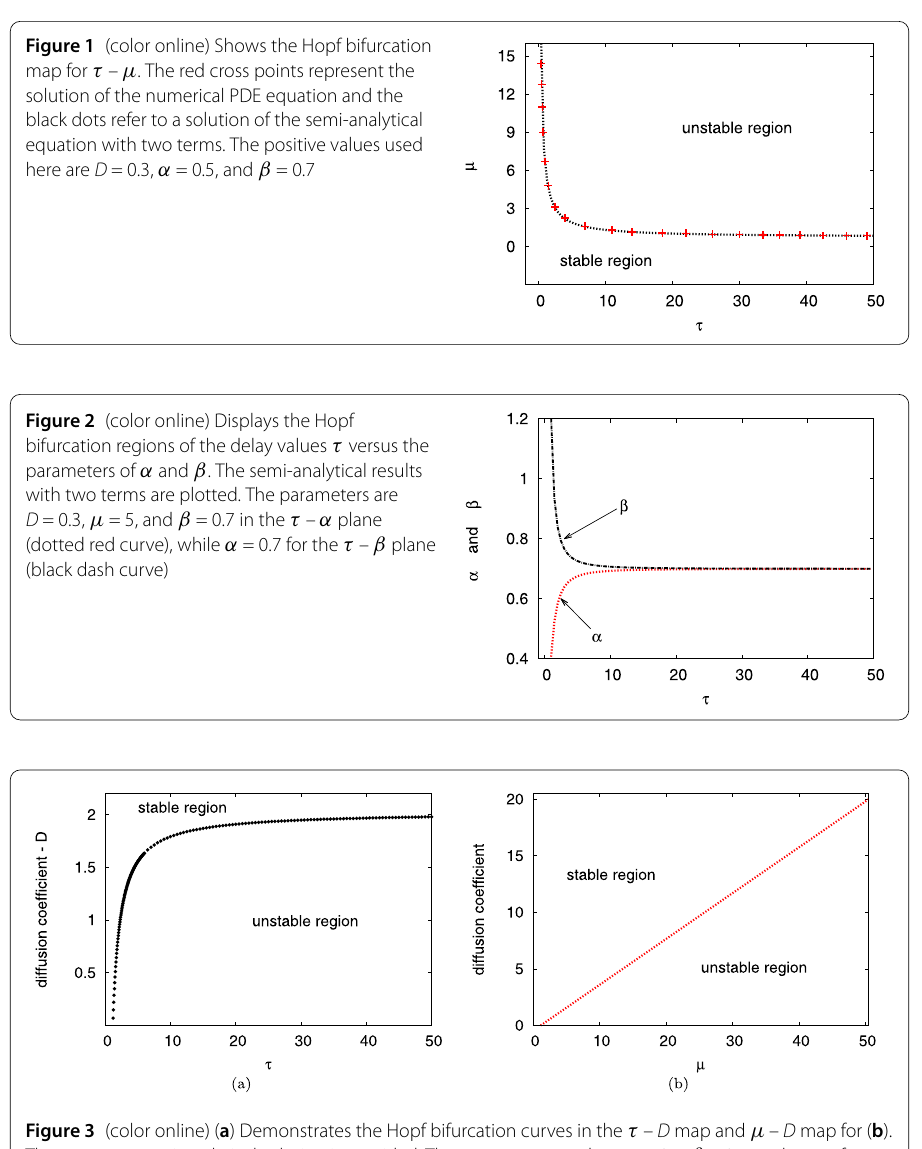
Figure 1 (color online) Shows the Hopf bifurcation map for τ – μ . The red cross points represent the solution of the numerical PDE equation and the black dots refer to a solution of the semi-analytical equation with two terms. The positive values used here are D = 0.3, α = 0.5, and β = 0.7